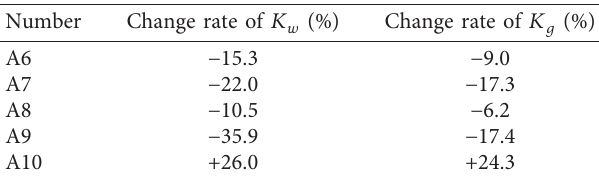
Figure 6: Water and gas permeability coefficient of concrete (28 d). Table 5: Change rates of permeability when comparing A3 with concrete with